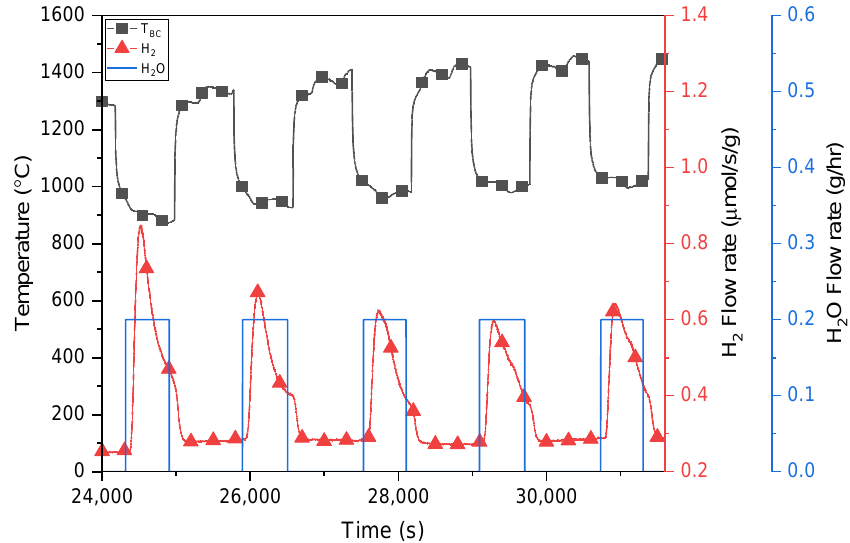
Figure 4. H 2 and H 2 O rates vs. time during 5 consecutive temperature-swing cycles with H 2 O splitting and the corresponding temperature profile of porous ceria. Symbols are for visual purposes only; the fidelity of measurements was on the order of 2 s.